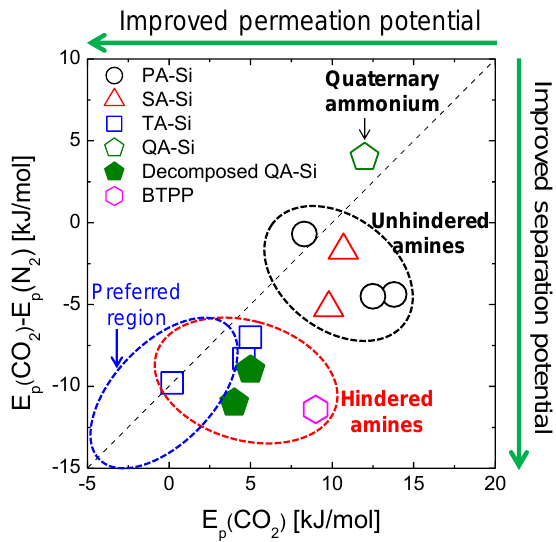
Figure 19. Relationships of E p ( CO 2 ) vs. E p ( CO 2 ) − E p ( N 2 ) for amine-functionalized organosilica membranes. The preferred region shown in the figure demonstrates lower values for both E p ( CO 2 ) and E p ( CO 2 ) − E p ( N 2 ). Results were reorganized from refs. [21–23].